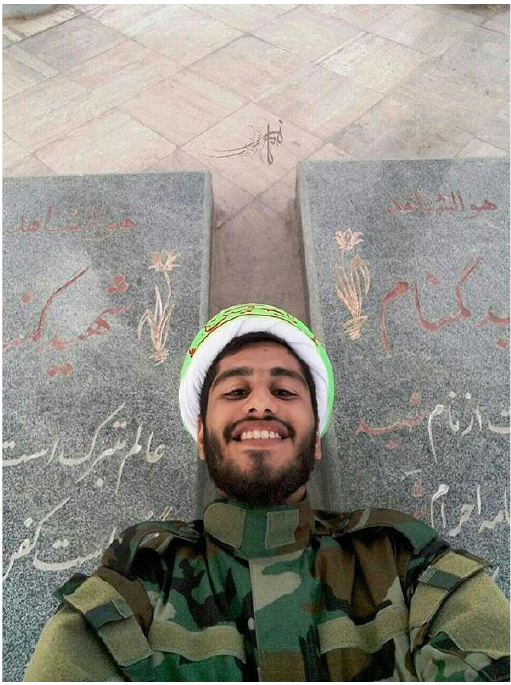
Figure 2. The selfie taken by Saeid Bayazizadeh, a seminary student who was reportedly martyred in Syria. While lying on the ground, he locates himself between two gravestones of “unidentified martyrs” buried in his military training camp. source: https://defapress.ir/fa/news/108536/ (cid:132)(cid:186)(cid:74)(cid:74) (cid:174)(cid:202)(cid:131) فلس ی- یک -هشی د-اب - ادهشی -مانمگ -سکع (accessed on 17 May